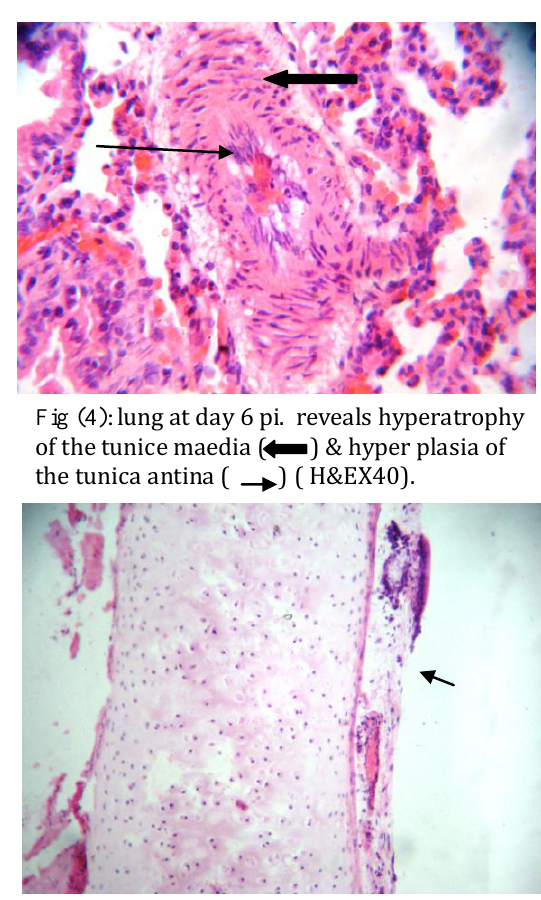
Fig (5): trachea at 16 hr pi. showed hemorrhages in the sub mucosa & also in the lumen with inflammatory cells infiltration mainly neutrophils & lymphocytes( H&EX10).